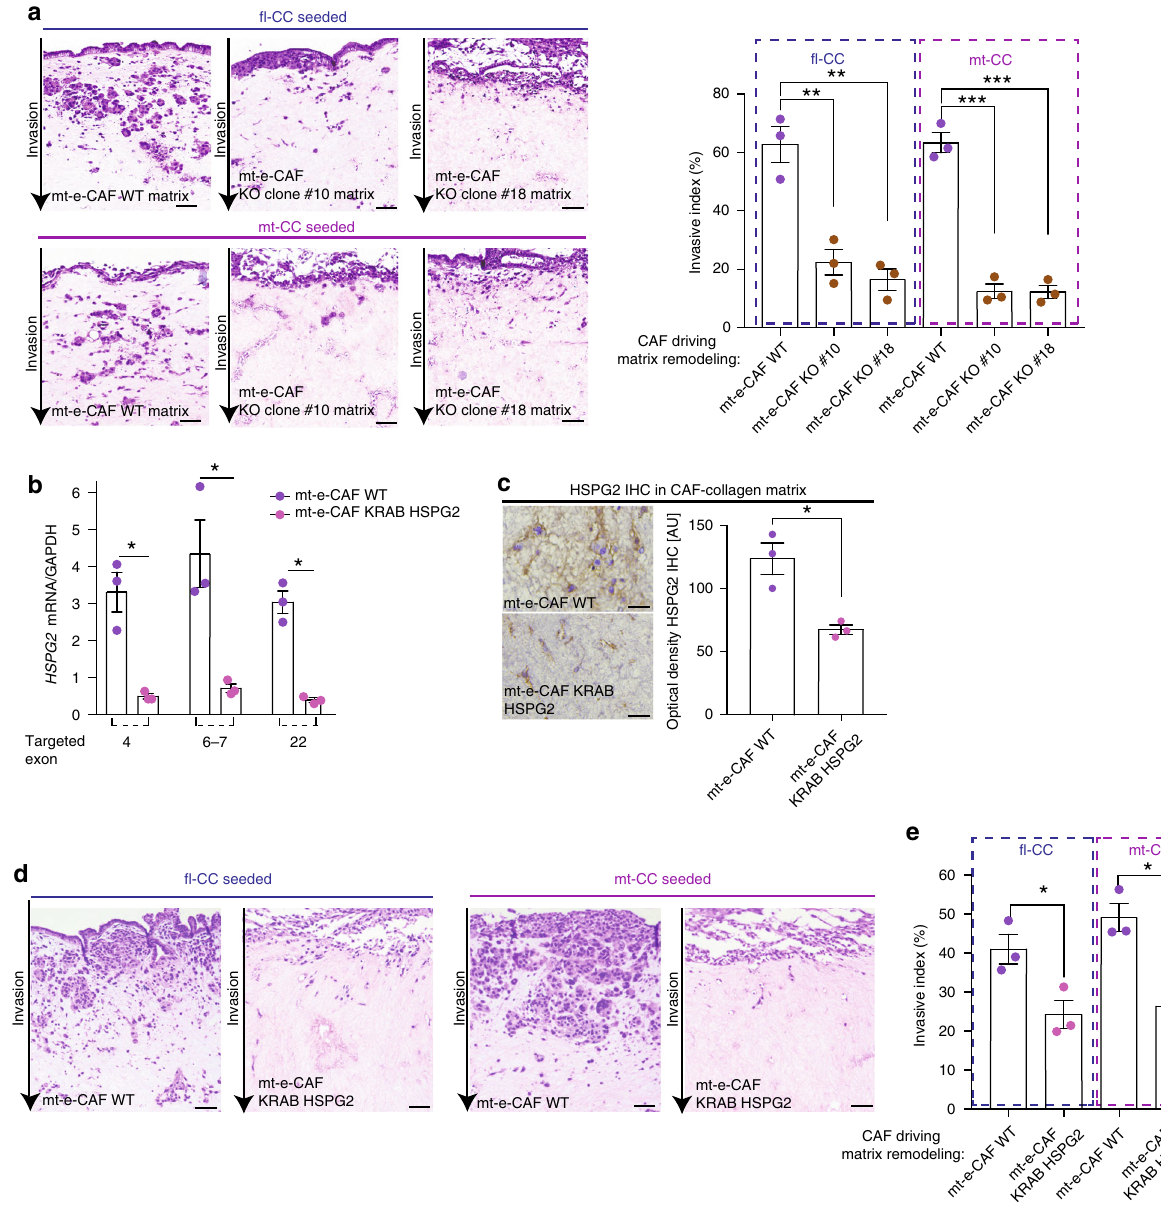
Fig. 5 Depleting HSPG2 deposition reduces cancer cell invasion. a Representative H&E images and quanti fi cation of invasive index for fl -CCs and for mt- CCs invading into matrices remodeled by mt-e-CAFs WT or by clones 10 and 18 isolated from the mixed population of mt-e-CAFs KO HSPG2. Scale bar: 100 μ m. b RT-qPCR analysis of HSGP2 mRNA in mt-e-CAFs WT and in mt-e-CAFs transfected with a KRAB HSPG2 construct. c HSPG2 IHC staining and quanti fi cation of optical density in collagen matrices generated by mt-e-CAFs WT or by mt-e-CAFs transfected with the KRAB HSPG2 construct. Scale bar: 100 μ m. d Representative H&E images and e quanti fi cation of invasive index for fl -CCs and for mt-CCs invading into collagen matrices generated by mt-e- CAFs WT or by mt-e-CAFs transfected with a KRAB HSPG2 construct. Scale bar: 100 μ m. All experiments were conducted with three biological repeats and with three technical replicates per biological repeat. Individual data points are presented with mean values and SEM. * p < 0.05, ** p < 0.01, *** p <